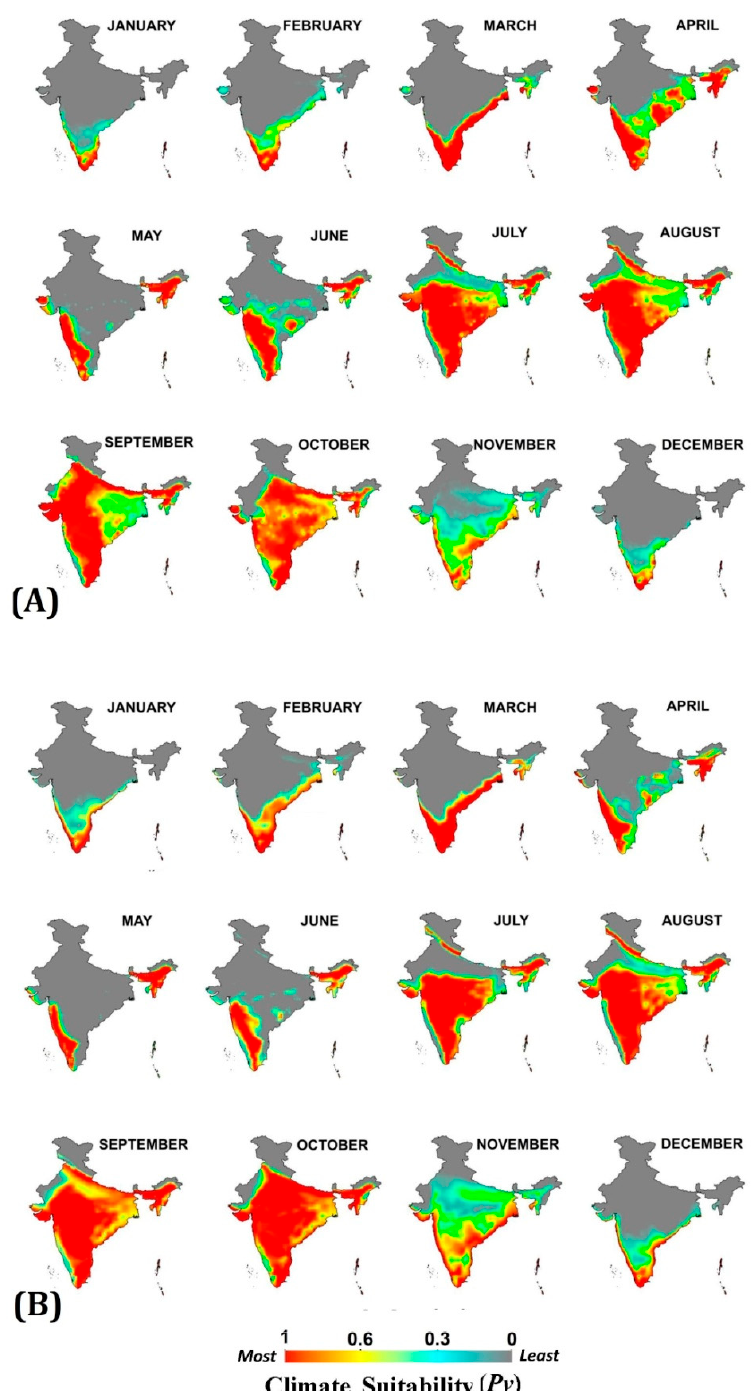
Figure 3. Monthly climate suitability maps for P. vivax malaria using Temperature and RH combined ( A ) Baseline (1976–2005) and ( B ) projected 2030s. Increased climate suitability is visible in the months of September to November, while reduction from April to June under the 2030s scenario, as compared to the baseline.